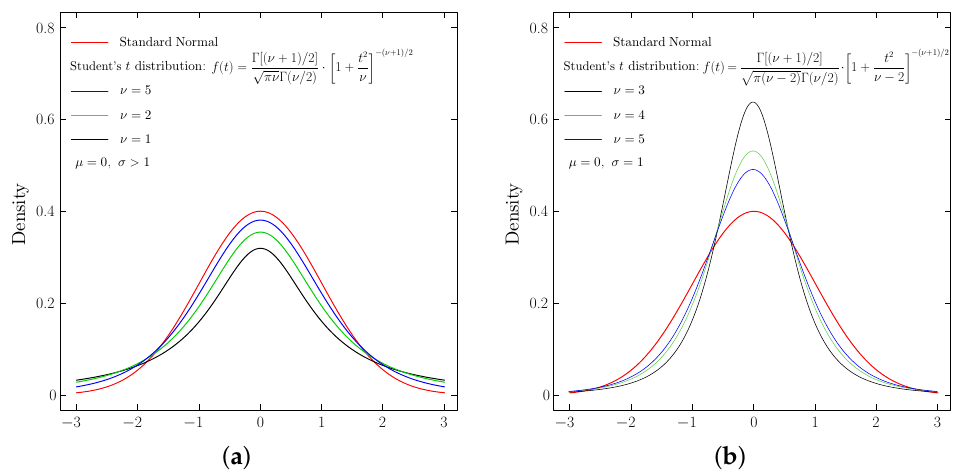
Figure 2. Student’s t distribution with non-unit variances ( a ) and unit variances ( b ). Author’s illustration. Notes: As the number of degrees of freedom ν increases, both kinds of Student’s t distribution approach normal distribution. This holds true for the case of their skewed distributions, too.